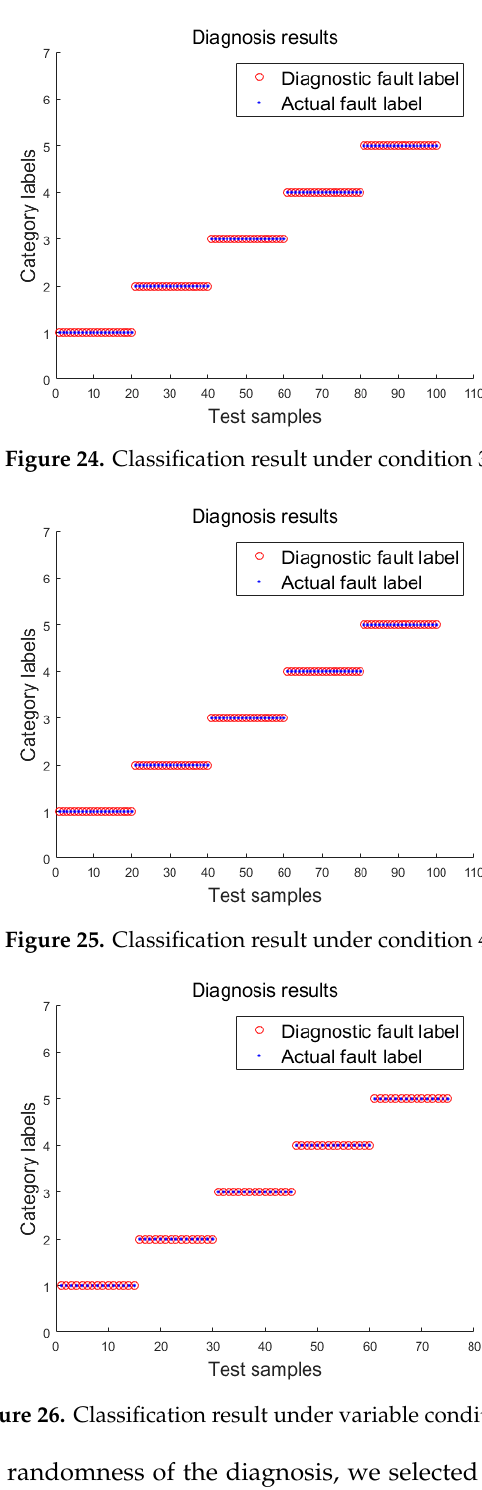
Figure 23. Classification result under condition 2.